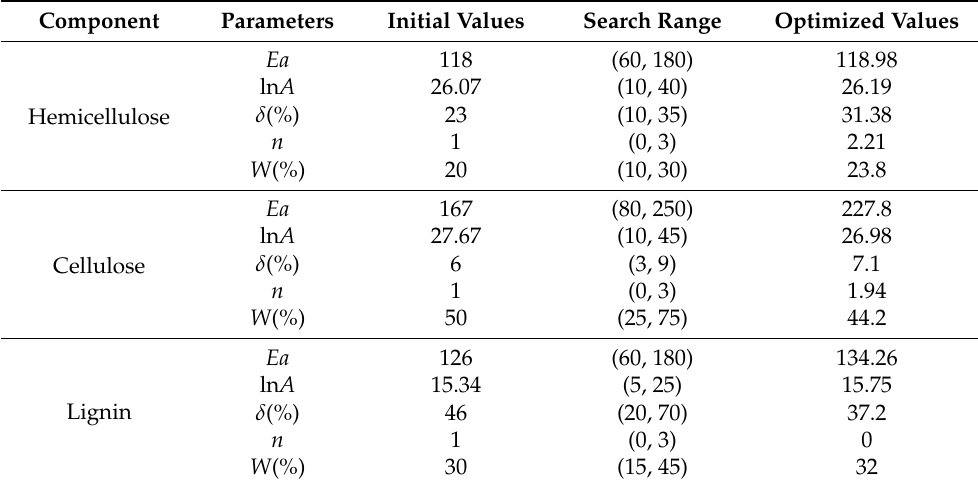
Table 7. Optimization parameters and results by particle swarm optimization